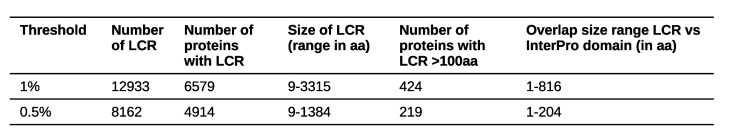
Values for different low-complexity region (LCR) parameters obtained from the 1% and 0.5% analysis threshold.